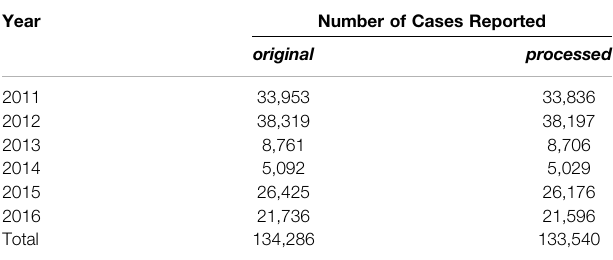
FIGURE 1 | Temporal evolution of the number of dengue cases. Here, weshowthenumberofreporteddenguecasesperdayinFortalezafrom2011 to 2016.